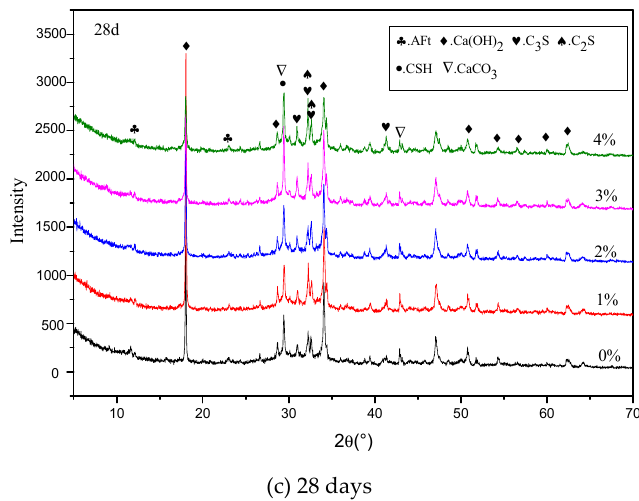
Figure 8. XRD spectrum results of the mixes with different contents of Na 2 CO 3 at ages of ( a ) 1, ( b ) 7, and ( c ) 28 days.